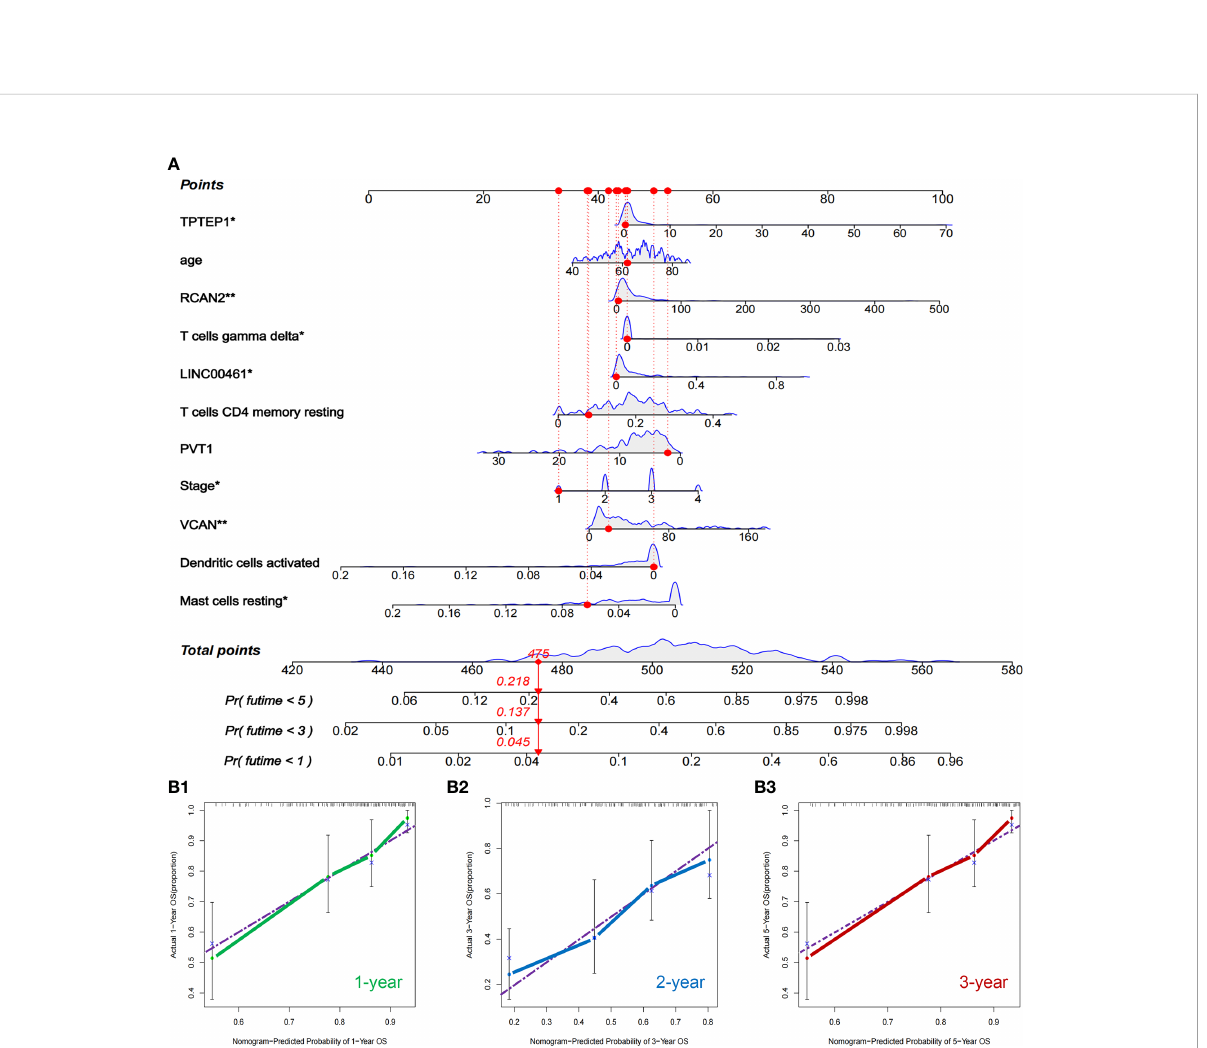
Bold indicates that the result is